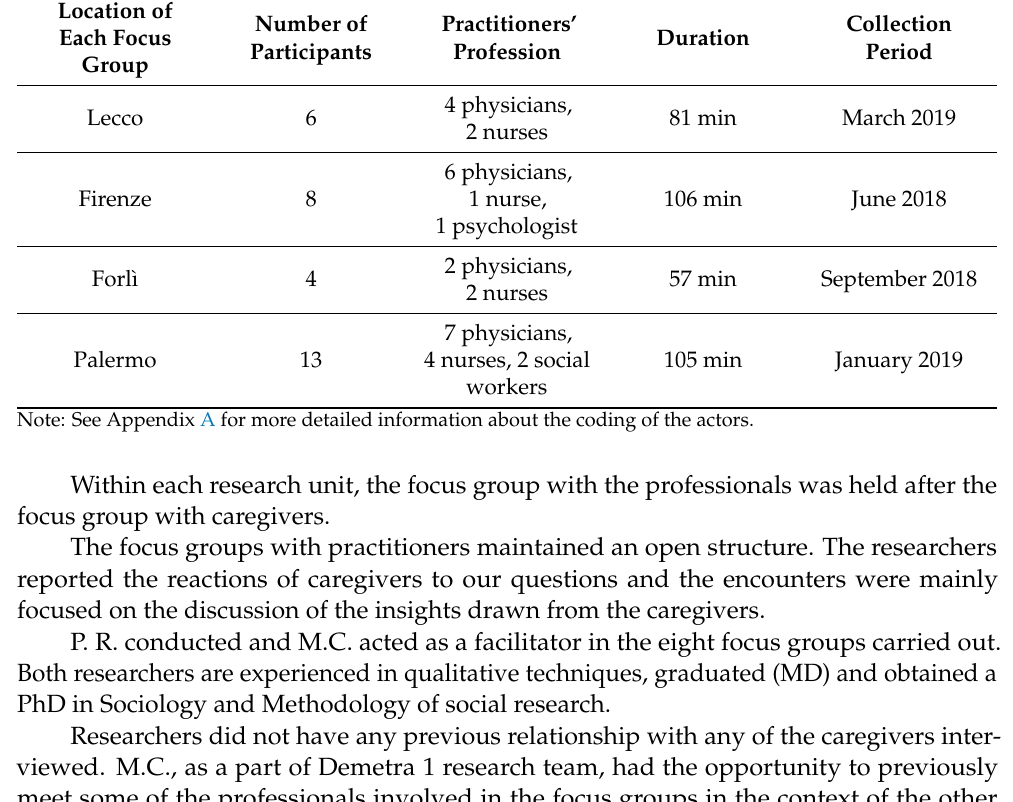
Table 2. Number and professions of practitioners who participated to the focus groups. Location of Each Focus